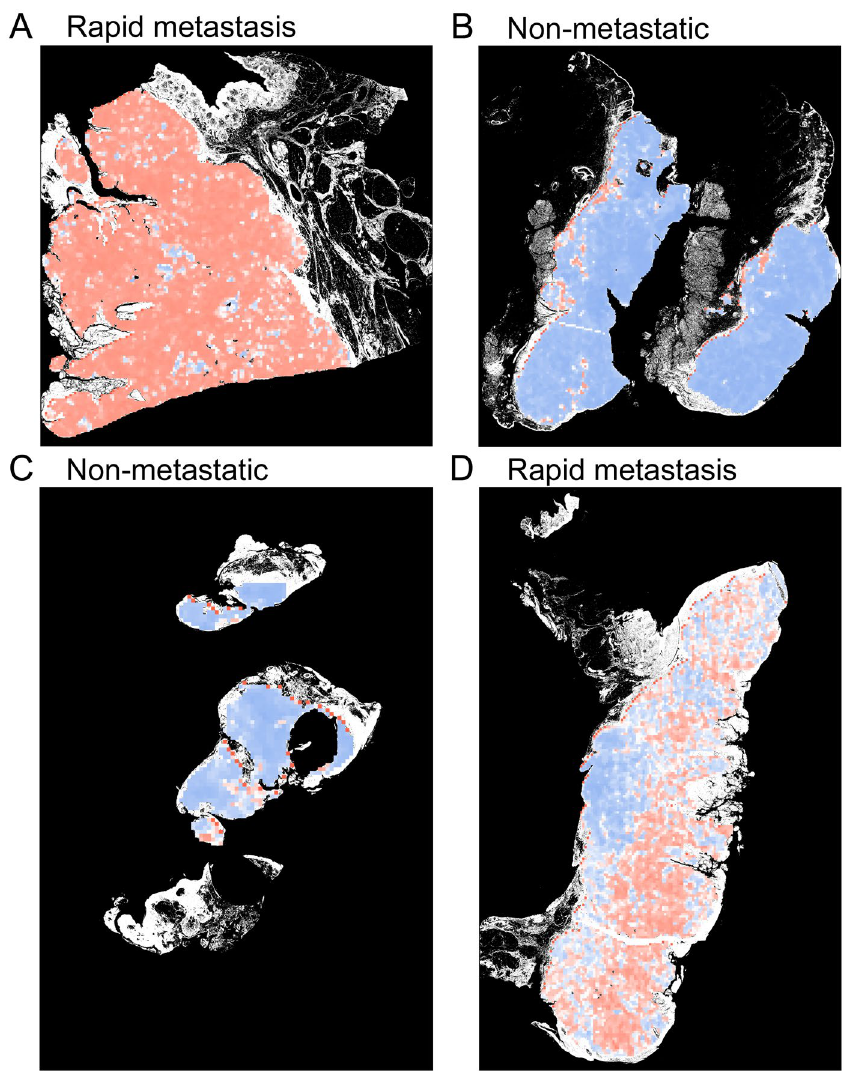
Figure 5. Probability maps of annotated whole slide images analyzed by artificial intelligence (AI). The color in the probability map indicates the predicted metastasis score by AI on tile level in annotated tumor area. Red color represents high and blue color low score i.e. red color indicates tiles analyzed as metastatic and blue color tiles analyzed as non-metastatic by AI algorithm. White color on the edge of the slides represents excluded tissue outside manual annotations. ( A ) and ( D ) represent rapid metastasis and ( B ) and ( C ) non-metastatic cSCCs that were classified correctly on slide level by